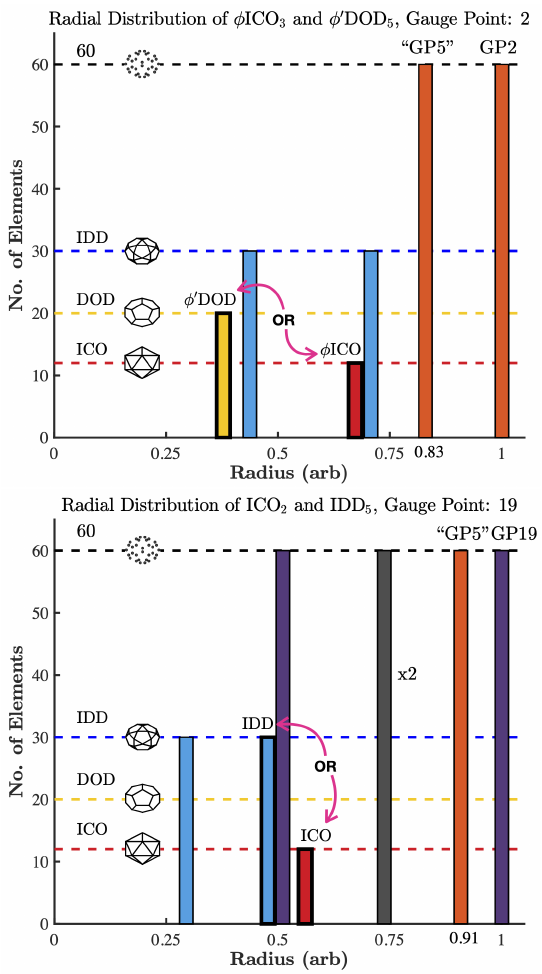
Figure 4. Gauge points impose a set of geometric constraints at different radii and angular locations throughout the capsid and genome. Here, we present 4 of the 55 base point arrays [3–5]. ( top ) Gauge point 2, located along the 5–3 great circle (orange), is created by φ (cid:48) DOD 5 (200 points) and φ ICO 3 (192 points). There are two sister arrays